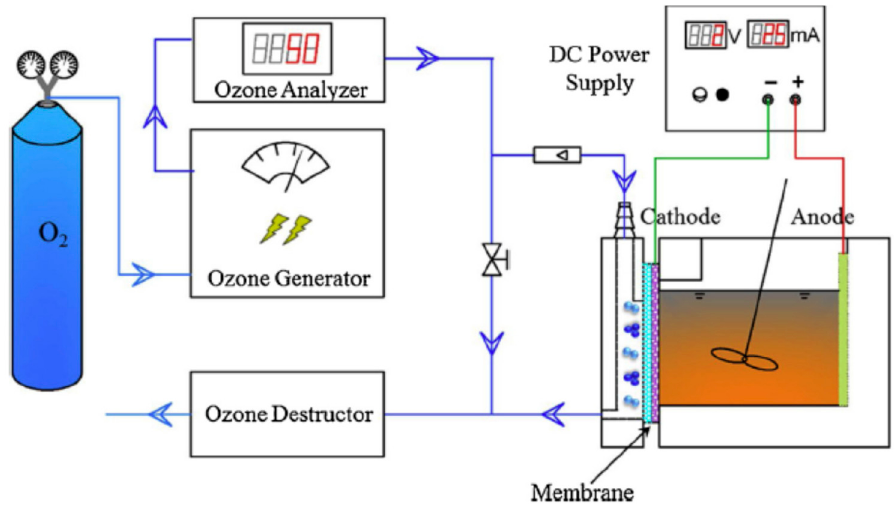
Figure 10. Schematic of the experimental setup [43].